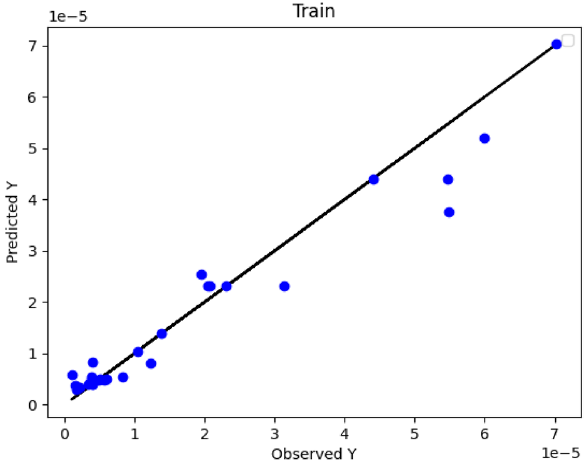
Figure 3. ADA-DT Model: actual versus predicted values/Y: solubility.